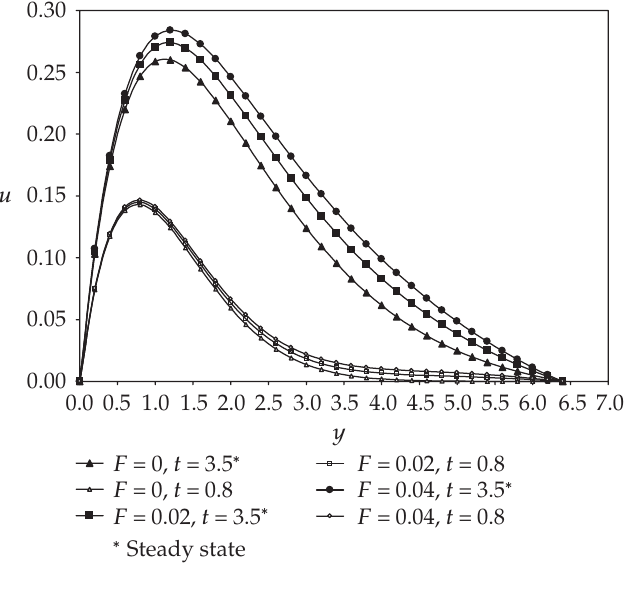
Figure 5.1 . Transient velocity profiles for the di ff erent values of F and for the values x = 1, M = 1, m = 1, and Pr = 0 . 7.